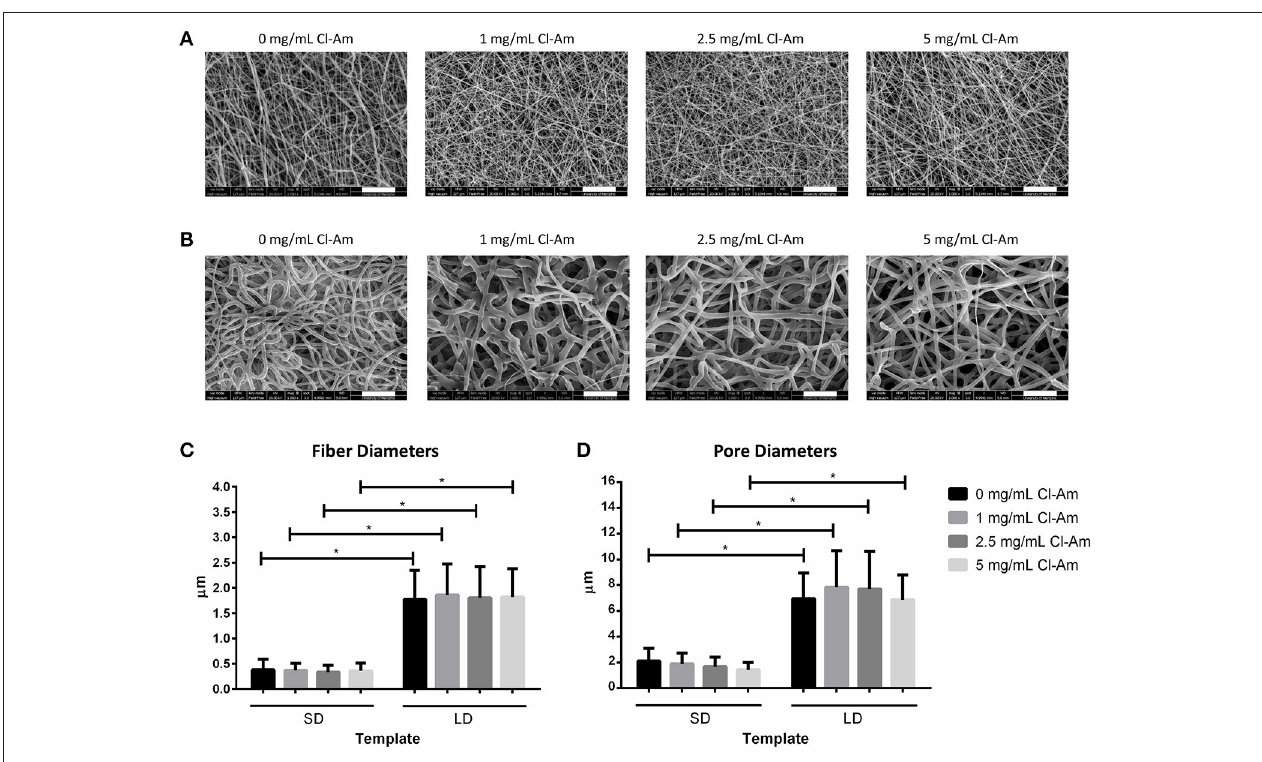
FIGURE 3 | PDO electrospins at low and high concentrations with Cl-Am. Representative SEMs of (A) SD and (B) LD templates with 0–5 mg/mL Cl-Am (scale bars = 20 µ m). For all drug concentrations, all SD and all LD templates have statistically equivalent (C) fiber and (D) pore diameters; however, at each drug concentration, SD templates have significantly smaller (C) fiber and (D) pore diameters than the large diameter templates. *Significant difference ( p < 0.05). (mean ± std. dev., n > 250 for fiber diameter analysis and n = 60 for pore diameter analysis).